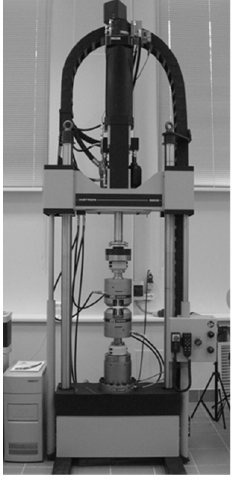
Figure 8. Instron 8850 servohydraulic test system.